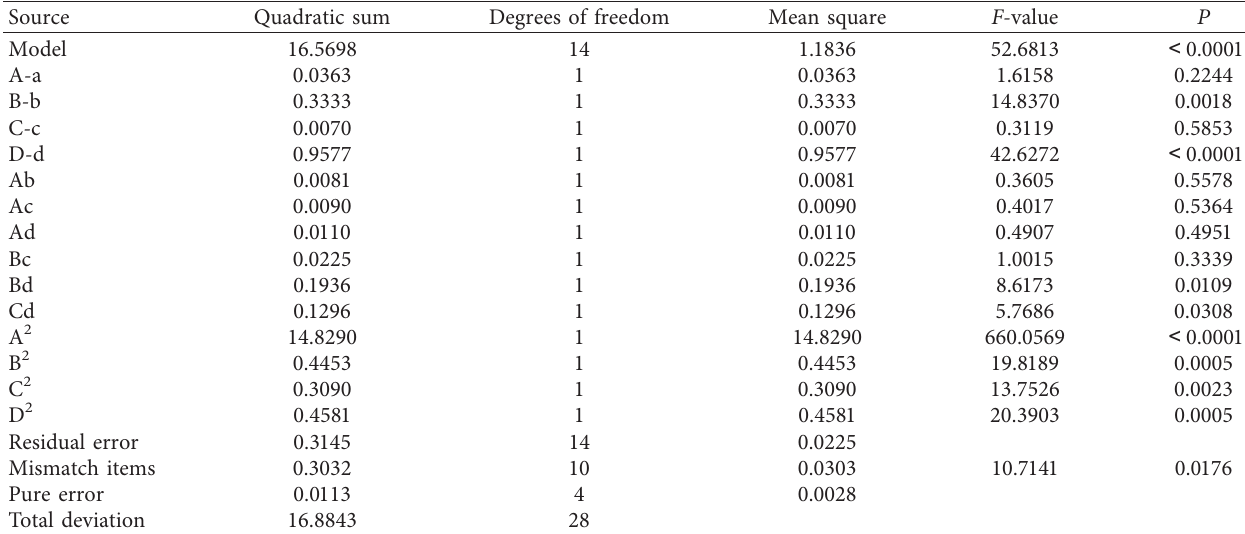
Table 6: Variance analysis of the regression